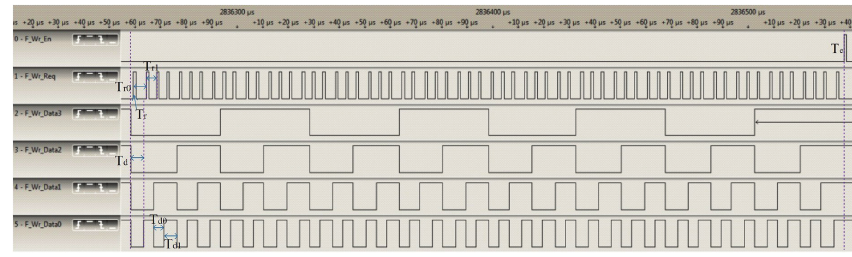
Figure 14: Data and Timing Waveform when Multiplexer Writing to FIFO-I, via